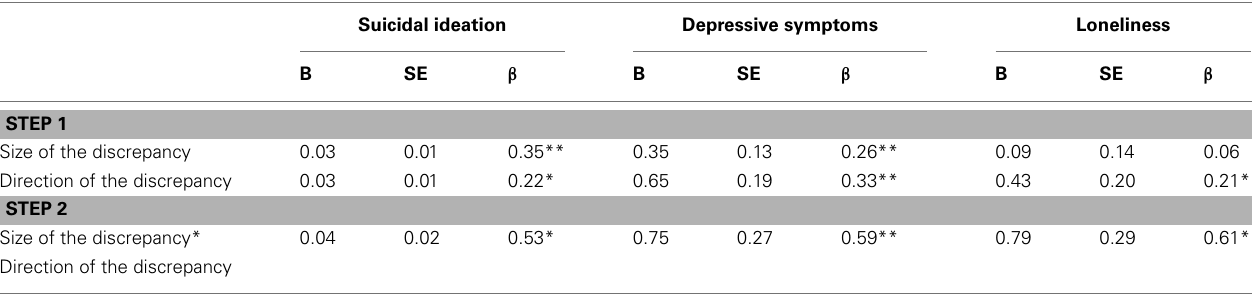
TableA2 | Hierarchical multiple regression analyses: associations of the size of the discrepancy, direction of the discrepancy, and the interaction between the size of the discrepancy and the direction of the discrepancy with suicidal ideation, depressive symptoms, and loneliness. Suicidal ideation Depressive symptoms